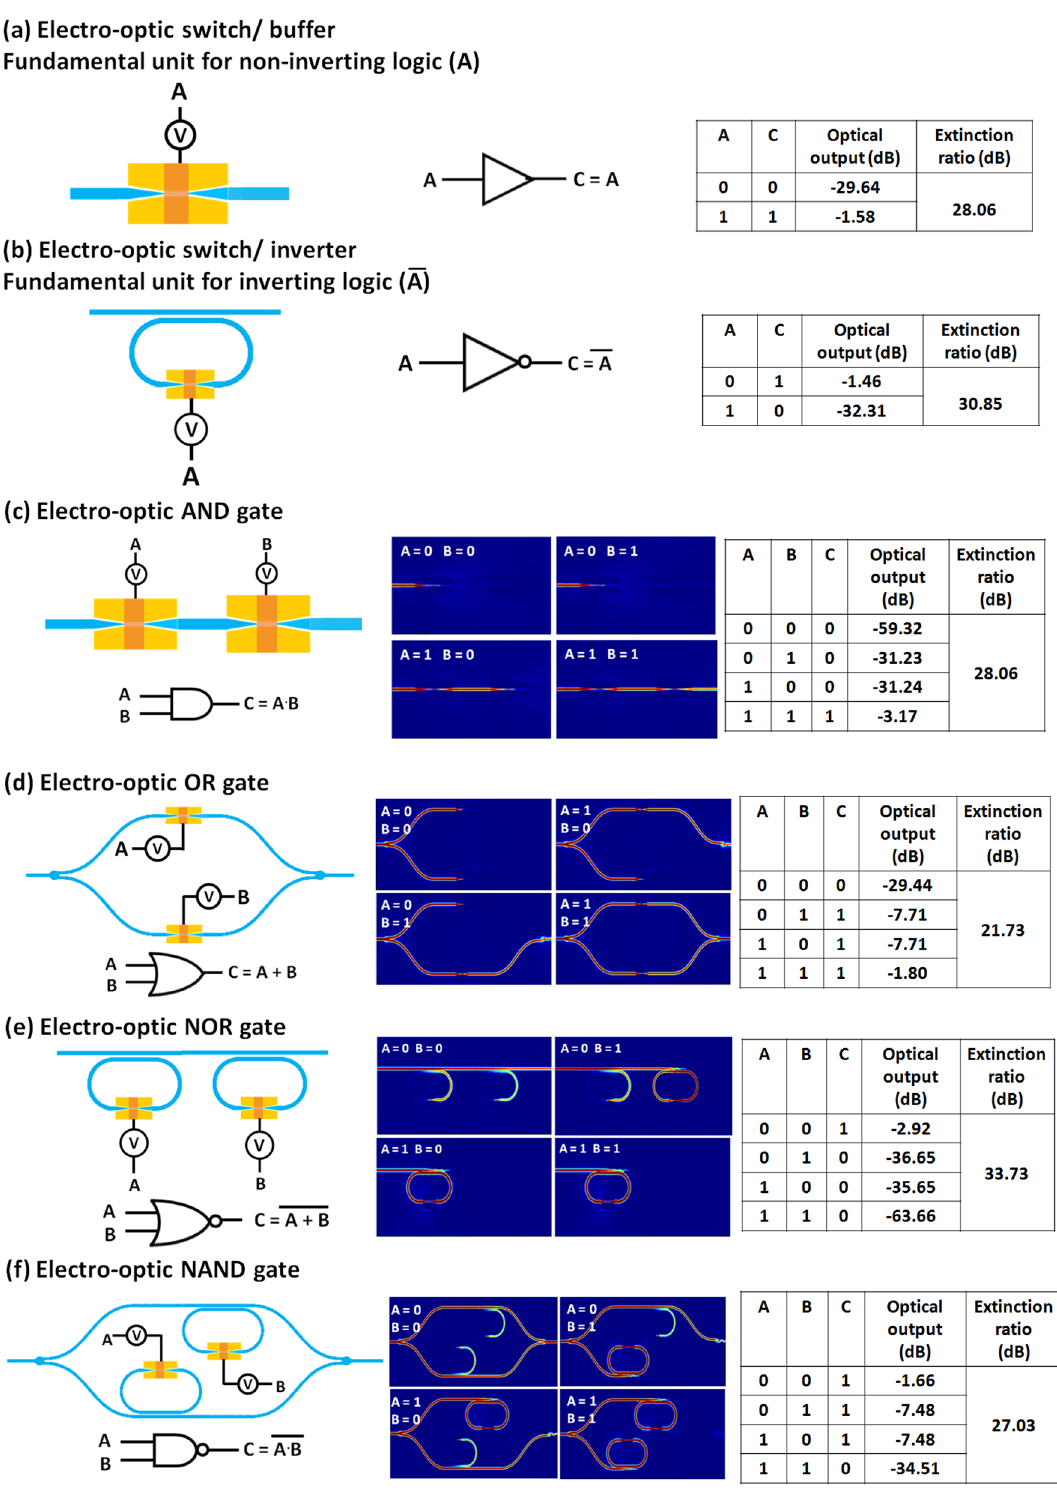
Figure 4. Electro-optic configurations, graphical symbols, and truth tables of: ( a ) fundamental unit of non- inverting logic, ( b ) fundamental unit of inverting logic, ( c ) AND logic, ( d ) OR logic, ( e ) NAND logic, and ( f ) NOR